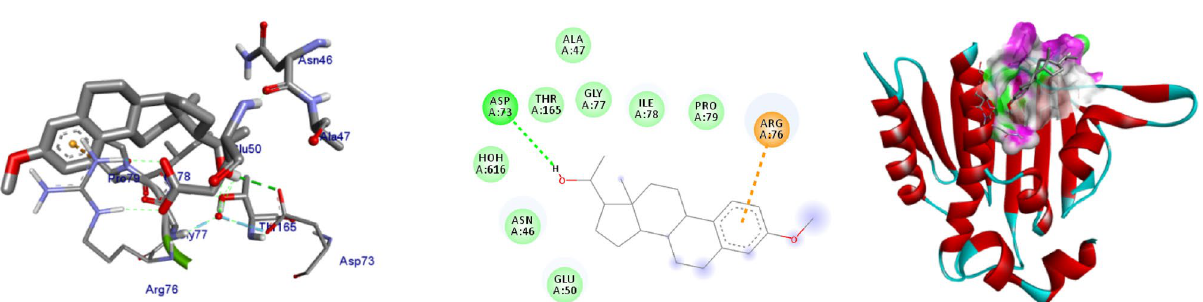
Figure 4. The 2D and 3D intermolecular contact between compound 4 and DNA gyrase B (PDB ID: 6F86). Chemical structures were drawn by ChemDraw Pro 16.0 Suite (PerkinElmer, USA) and analyzed by the Discovery studio visualizer (BIOVIA Discovery studio 2020 Client).